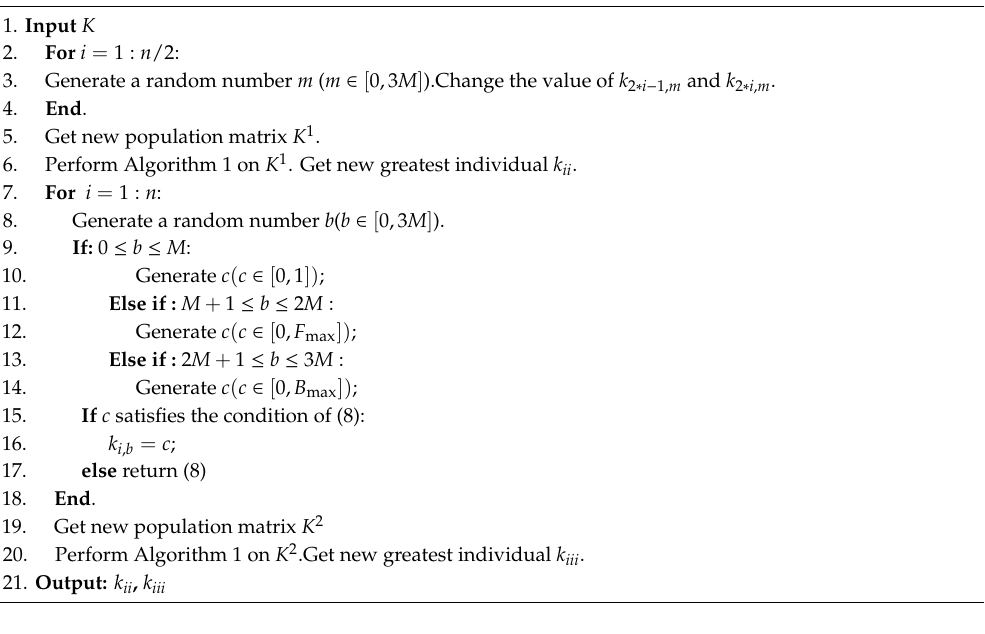
Algorithm 2 Crossover and mutation